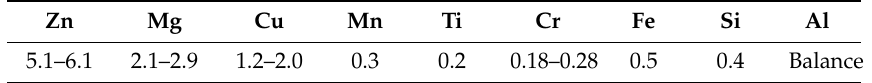
Table 1. Composition of aluminum alloy 7075-T6 (wt.%).